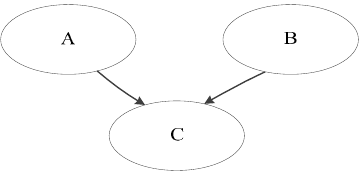
Figure 1. A simple Bayesian network.